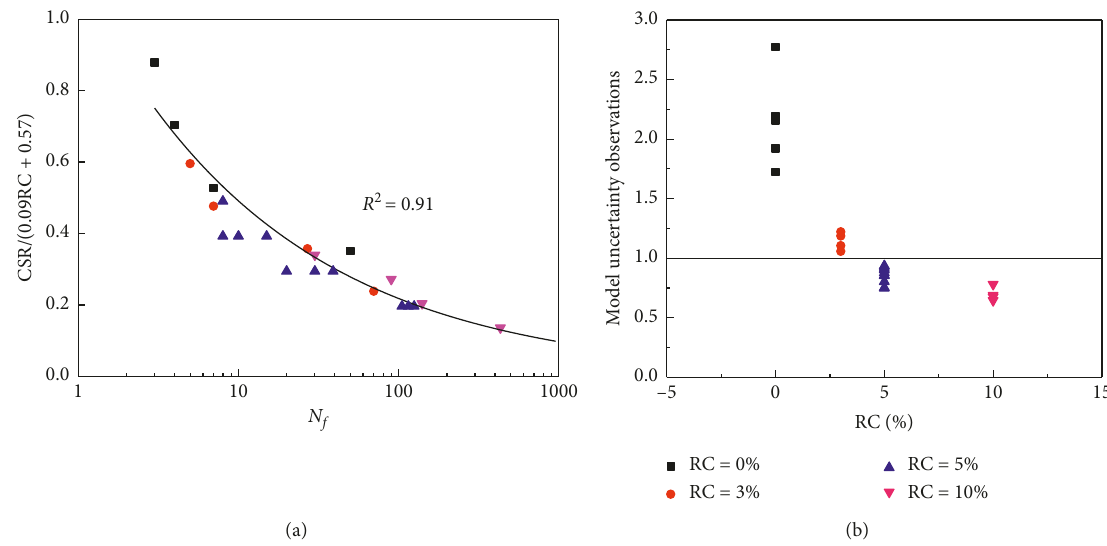
Figure 13: Fitting correlation between CSR/ ( 0 . 09RC + 0 . 57 ) and the number of cycles ( N uncertainty observations θ versus RC.